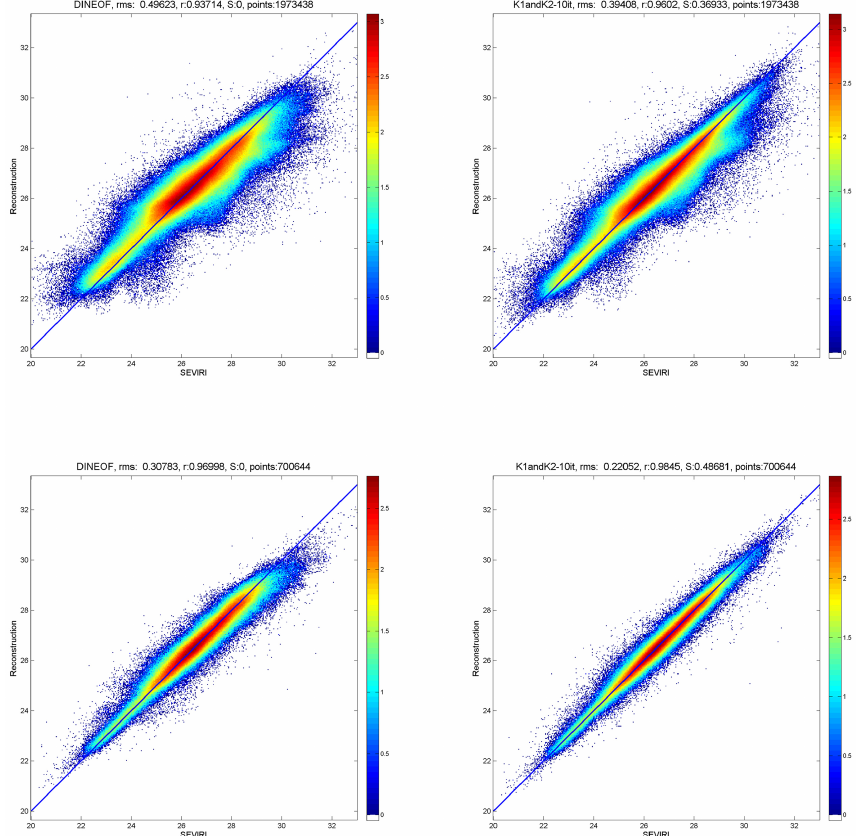
Figure 3. Correlation at cross-validation points using DINEOF alone and the new method DINEOFOI in Setup 1 (top) and Setup 2